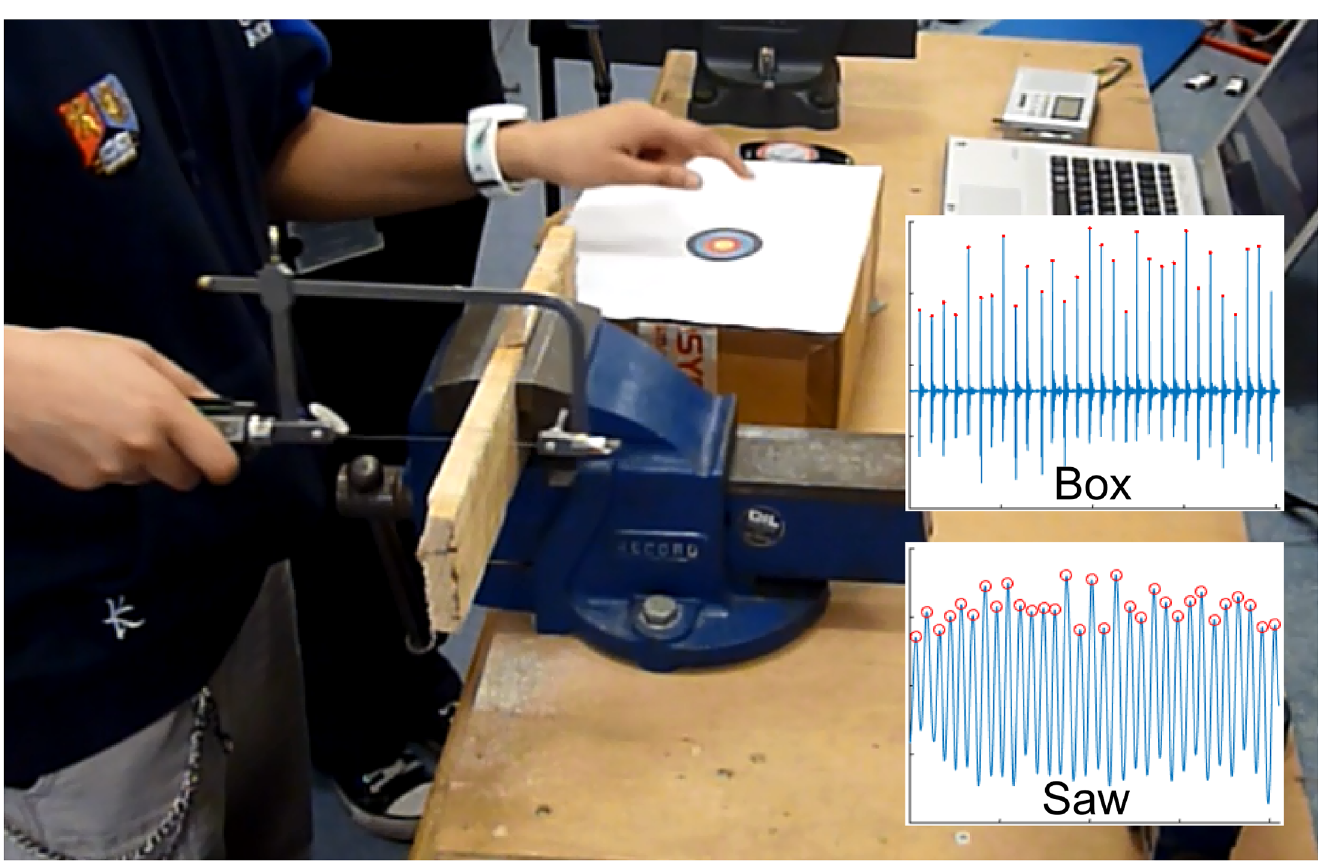
Fig 1. Study setup, illustrating the dual movement task where participants saw into a piece of wood while simultaneously tapping on a box to the beat of a metronome. Data from accelerometers attached to saw and box (inset) are recorded wirelessly.